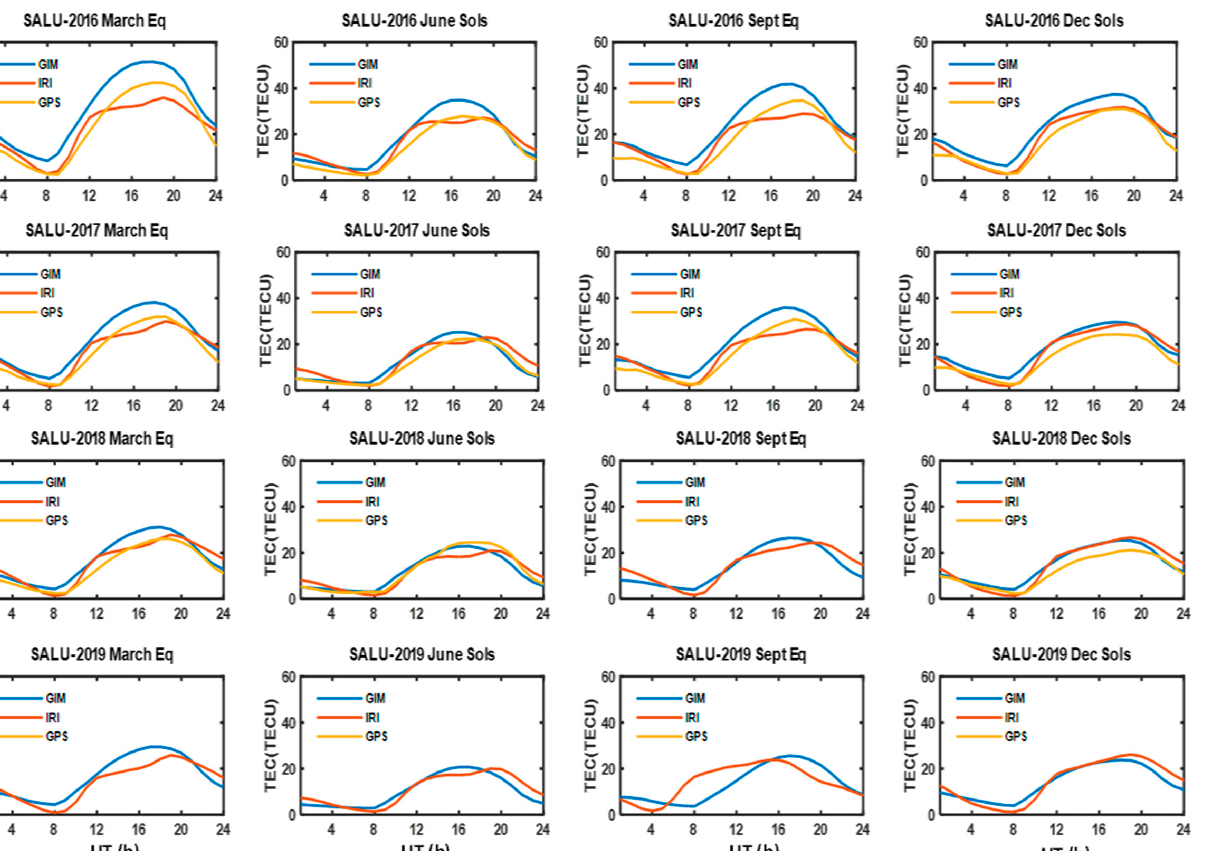
Figure 7. Seasonal variations in GPS-TEC, IRI-2016 and GIM models for descending (2016–2017) and minimum (2018–2019) phases of solar cycle 24 at POVE.